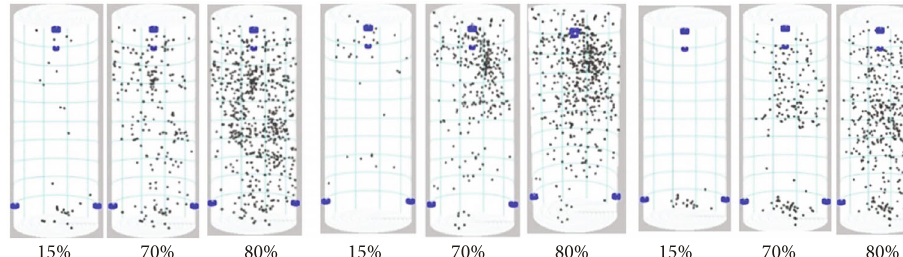
Figure 8: Distributions of the fractured sources of specimens